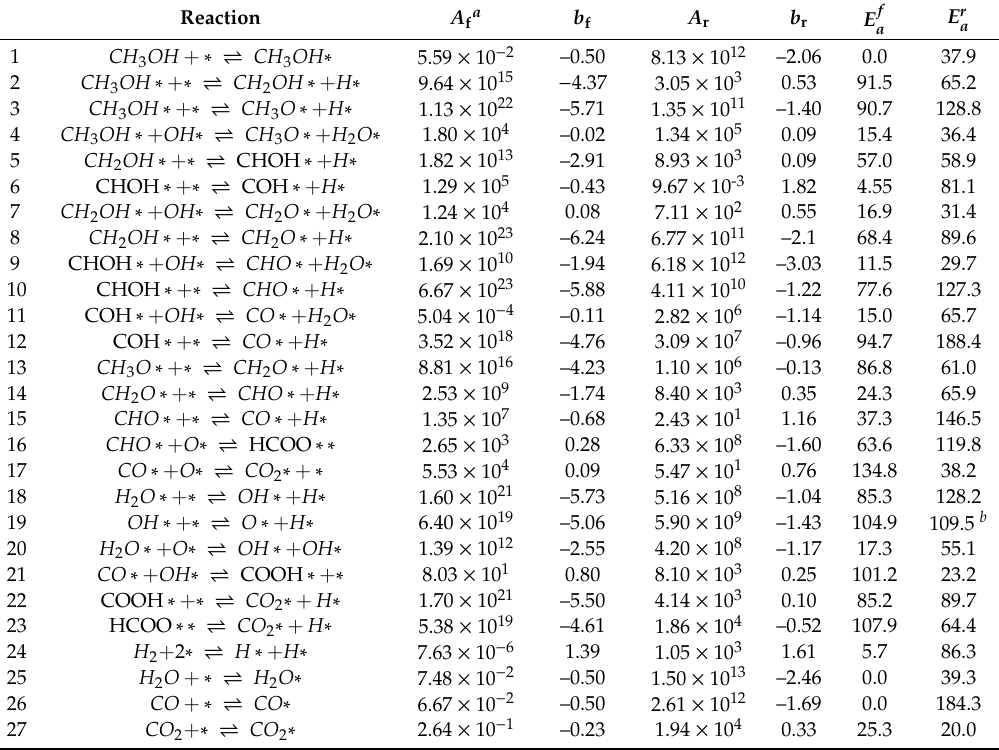
Table 2. Rate constant parameters of the elementary reaction steps of methanol steam reforming. The parameters are used to compute the temperature-dependent rate constants through Equation